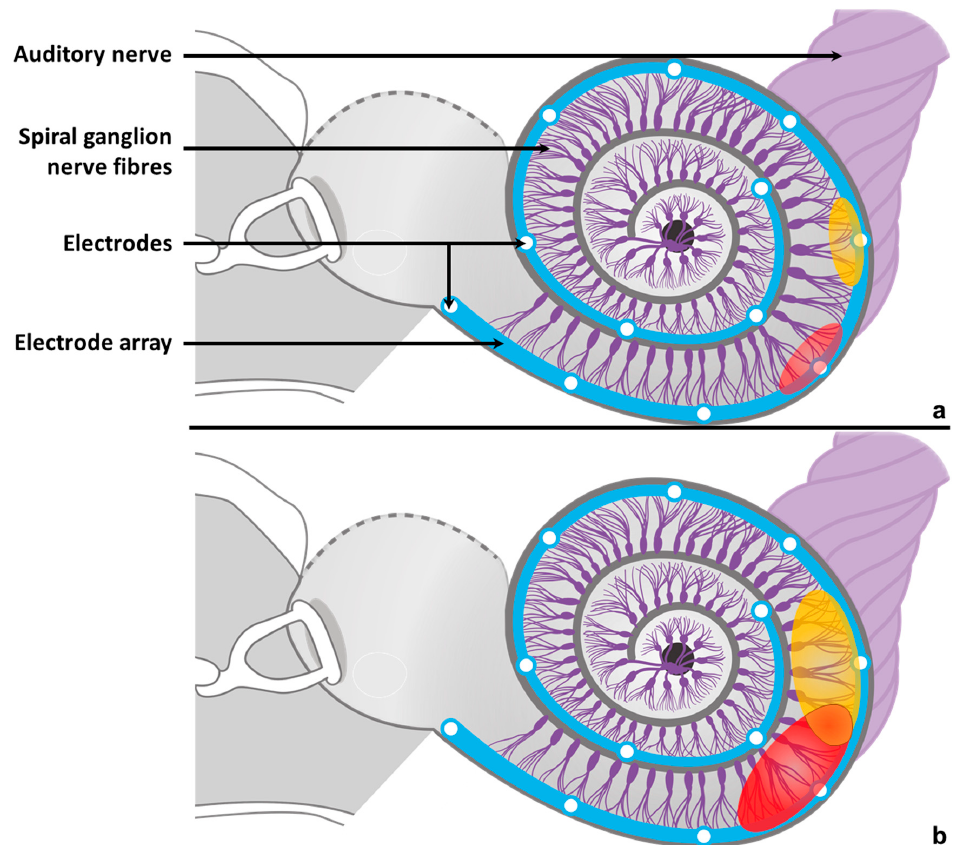
Figure 1. Examples of interactions induced by the intracochlear spread of current from the cochlear implant. Whenever the cochlear implant’s electrode array delivers electrical stimulations (red and yellow areas), the current spreads from each activated electrode to the surrounding neural tissue. If the spread is limited ( a ), each electrode will stimulate a distinct part of the neural tissue and thus evoke its own auditory sensation independent of the others. For a larger current spread ( b ), a shared part of neural tissue is stimulated by adjacent electrodes at the same time with a higher risk of channel interaction (orange area), and distinguishing sounds evoked by the interacting electrodes may become more difficult.